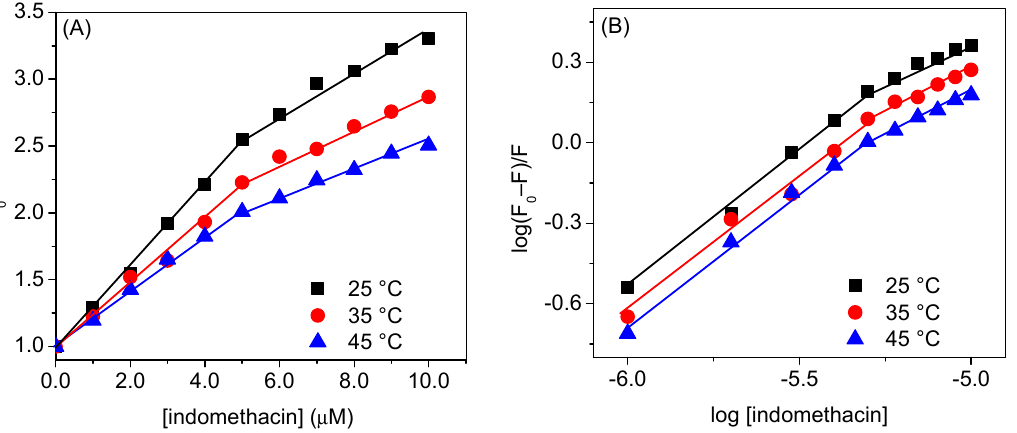
Figure 6. ( A ) Stern–Volmer plots of HSA-indomethacin interaction and ( B ) Plots of log (F 0 –F)/F versus log [indomethacin] at the excitation wavelength of 295 nm at various temperatures. Table 1. Stern–Volmer quenching constants (Ksv1, Ksv2), binding constants (kb1, kb2), and the number of binding sites (n1, n2) obtained from the observed and corrected fluorescence data of HSA–indomethacin interaction at 25 ◦ C by exciting the protein at 295